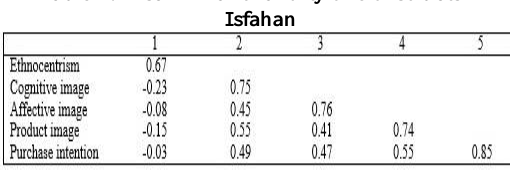
Table 4: Discriminant validity of Constructs in